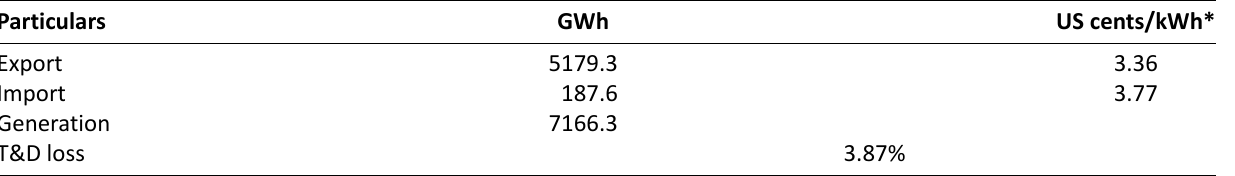
Table A1. Electricity sector key feature, based on BPC (2015). Particulars GWh